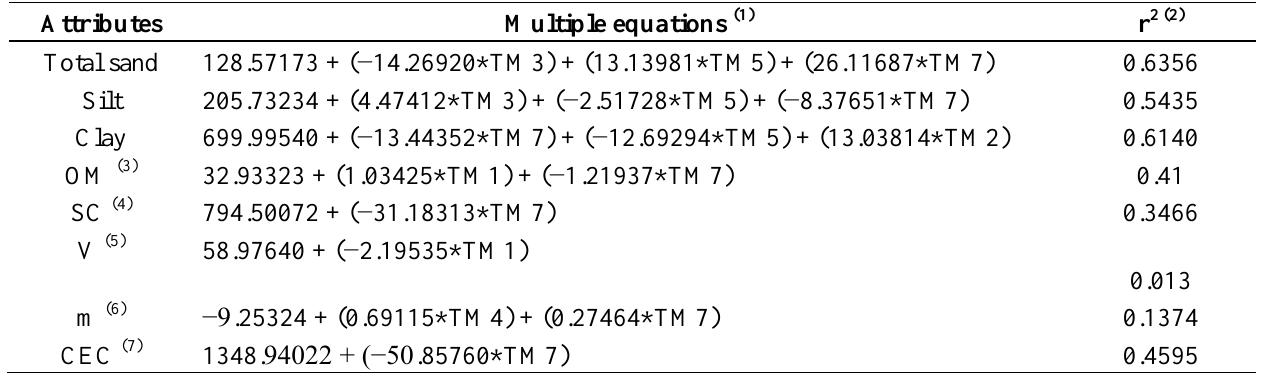
Table 6. Multiple regression equations to estimate soil attributes by orbital sensor using 6 bands (TM